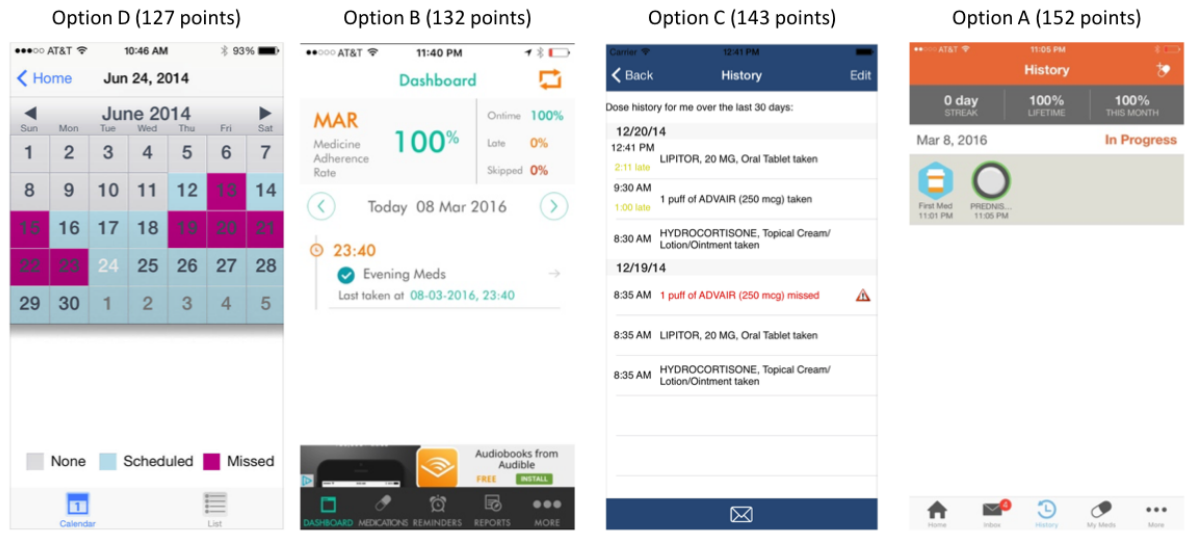
Figure 4. Medication Administration Record screenshots ranked from most preferred (lower score) to least preferred (higher score) based on design and visual appeal and respective scaled